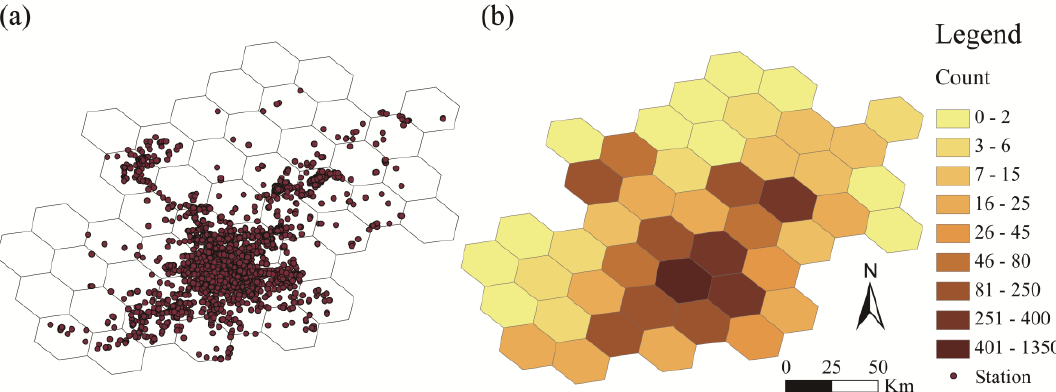
Figure 8. The distribution of public transportation stations in Beijing: ( a ) The distribution map of POI; and ( b ) The heat map of POI distribution expressed by hexagonal grid.